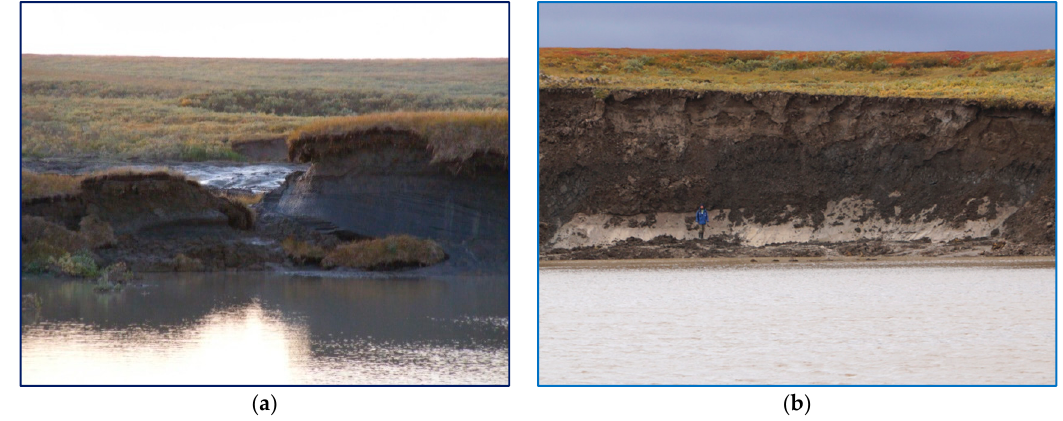
Figure 2. GEC lake walls with tabular ground ice: ( a ) GEC-1; ( b ) GEC-2.